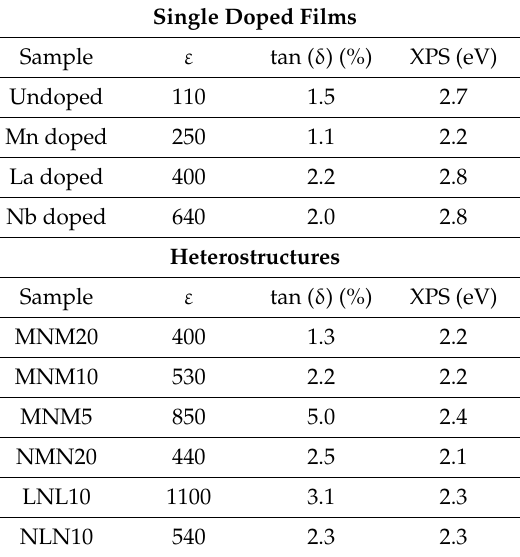
Table 2. Relative permittivity and dielectric losses values are shown for 100 kHz, 0 V and room temperature. XPS results are in situ E F (Fermi level position) —E VBM (valence band maximum) (eV) values for single doped films and ex situ E F -E VBM values for heterostructures. The abbreviations indicate tri-layer structures where M, N, and L correspond to Mn, Nb and La, respectively. Single Doped